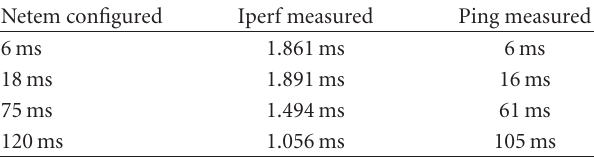
Table 3: Jitter measurements under